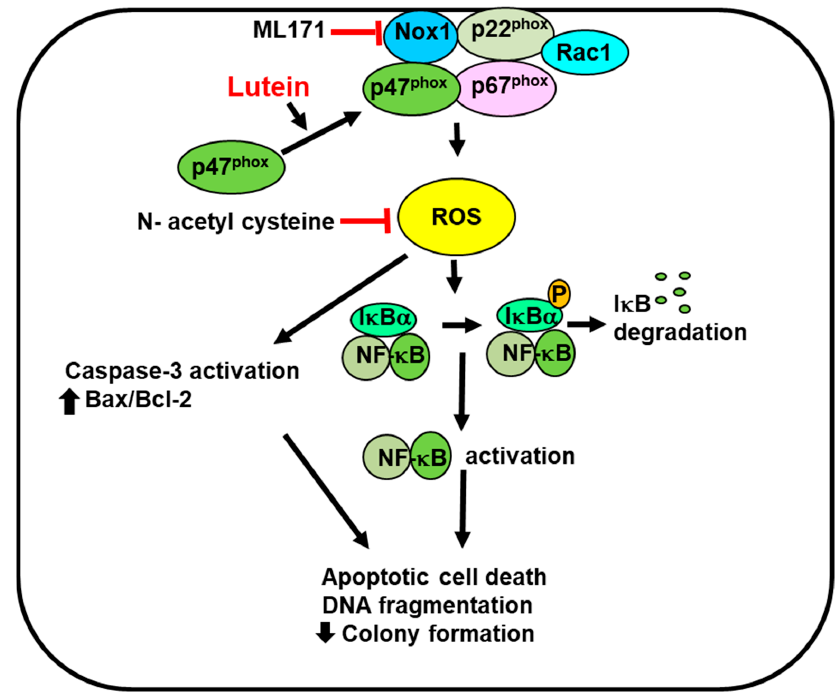
Figure 7. The proposed mechanism through which lutein stimulates NADPH oxidase, production of reactive oxygen species, NF- κ B activation, and apoptosis in gastric cancer AGS cells. Lutein increases NADPH oxidase activity by stimulating the translocation of cytosolic NADPH oxidase subunit p47 phox to the cell membrane to form a complex with membrane-bound subunit Nox1. It increases reactive oxygen species (ROS) production that induces degradation of I κ B α and activates NF- κ B. ROS stimu-